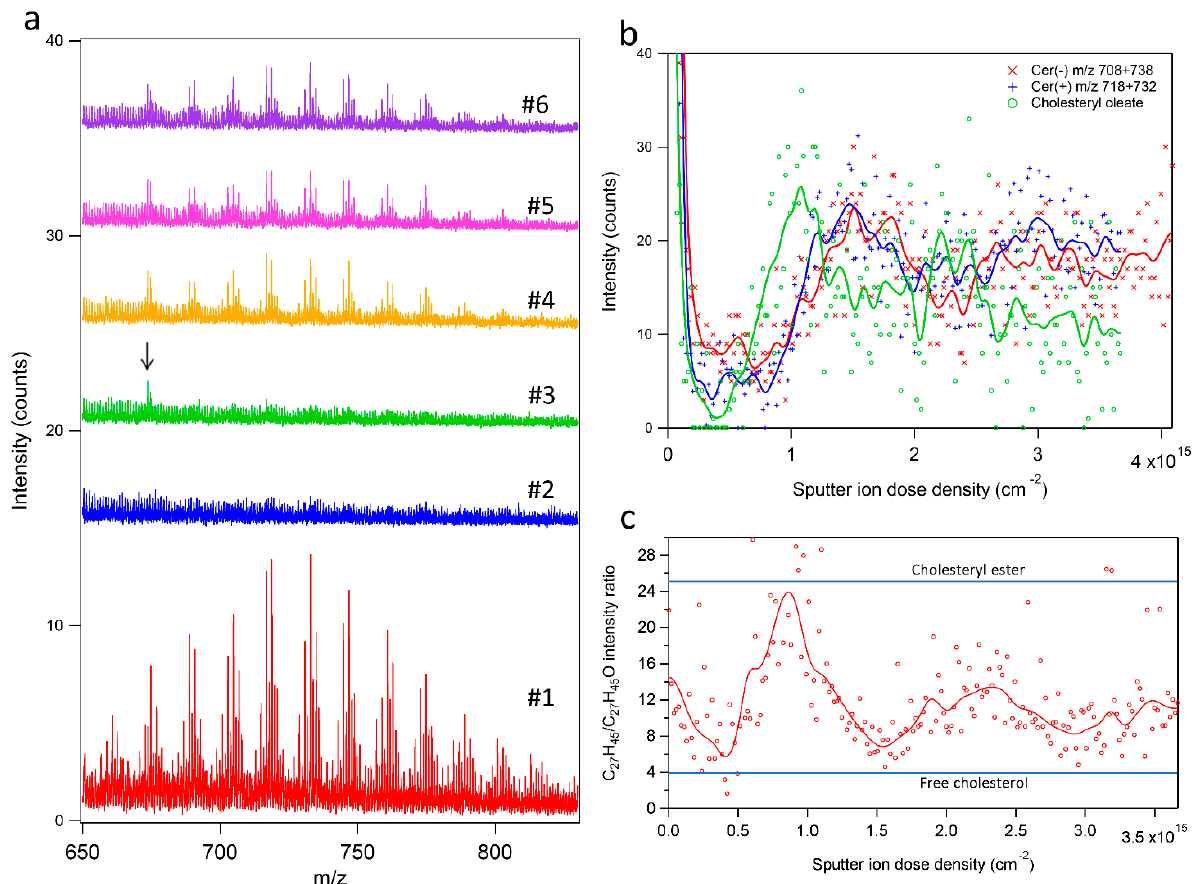
Figure 5. Variation in ceramide and cholesteryl oleate signal intensities with increasing sample depth. ( a ) Positive ion ToF-SIMS spectra in a mass range including molecular ceramide ions extracted from different depth intervals as shown in Figure 3a. The signal intensity of each spectrum has been normalized with respect to the different acquisition times of each depth interval and an offset has been applied for each spectrum for improved presentation. The arrow indicates the peak assigned to cholesteryl oleate. ( b ) Depth profiles of selected ceramide ions in positive and negative ion mode (separate measurements) and for the molecular ion of cholesteryl oleate (C 45 H 78 O 2 Na + , positive ions). ( c ) Variation of the C 27 H 45+ /C 27 H 45 O + signal intensity ratio with increasing depth into the skin sample. Note clear oscillations indicating changes between cholesterol esters and free cholesterol with increasing depth. Symbols in ( b ) and ( c ) are data point and solid lines are results of digital smoothing of the data.